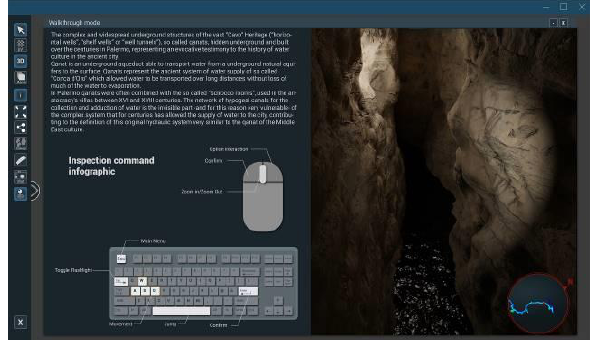
Figure 15 . UnReal Engine interface, gaming navigation mode inside the qanāt